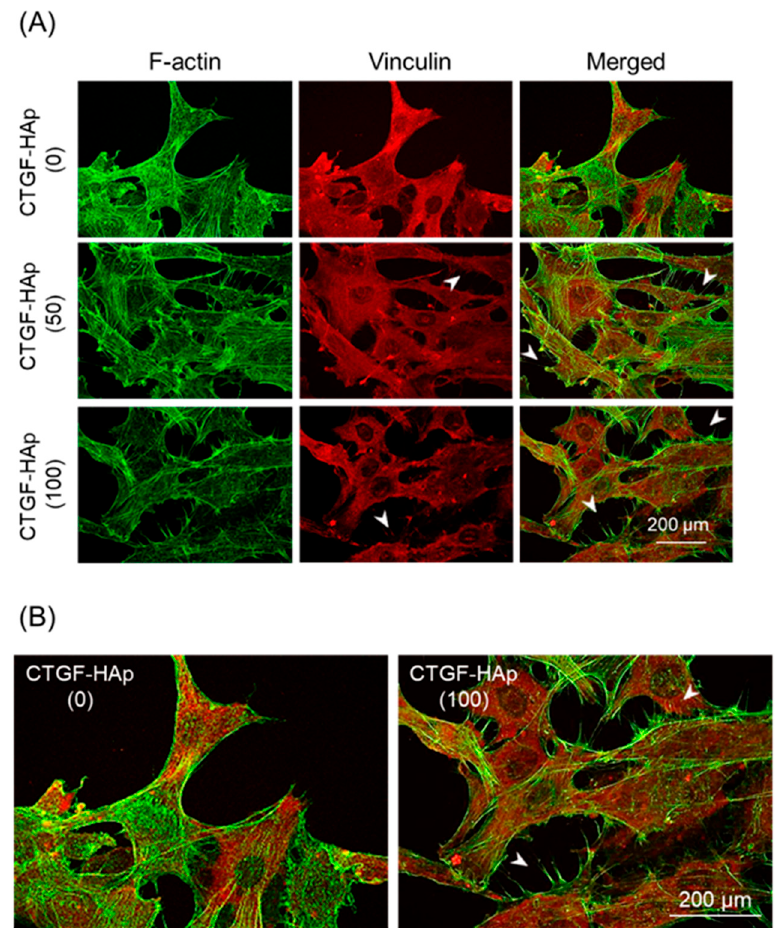
Figure 2. Immunostaining and fluorescence images of cell attachment at 24 h after plating. ( A ) Actin filaments were visualized with Alexa 488 phalloidin (green). Cells on CTGF-HAp ceramics were also immunostained with primary antibody against vinculin, followed by Alexa Fluor ® 594-conjugated secondary antibody. ( B ) Comparison with CTGF-HAp(0) and (100), regions in Figure 2A (merged) are magnified as insets. Arrowheads indicate filopodia-like structure. Bars represent 200 μ m .